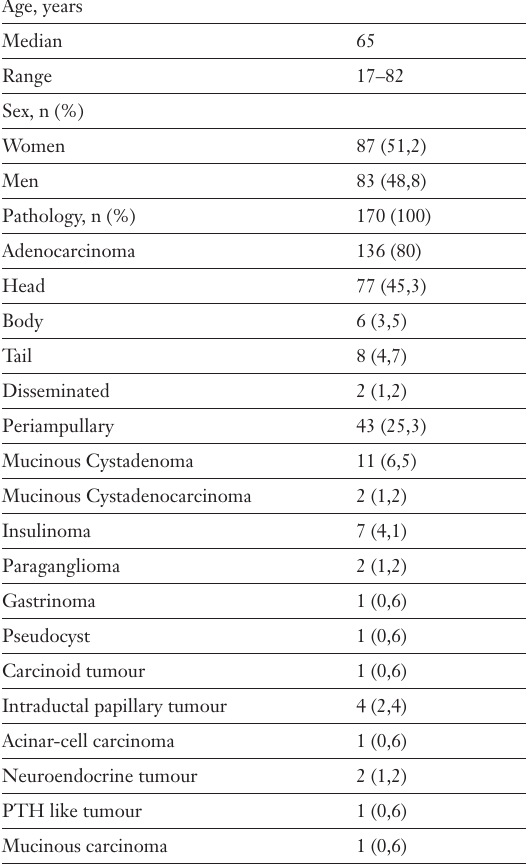
Table 1 Baseline characteris- tics and pathological findings in patients after surgery for pancreatic cancer (n =